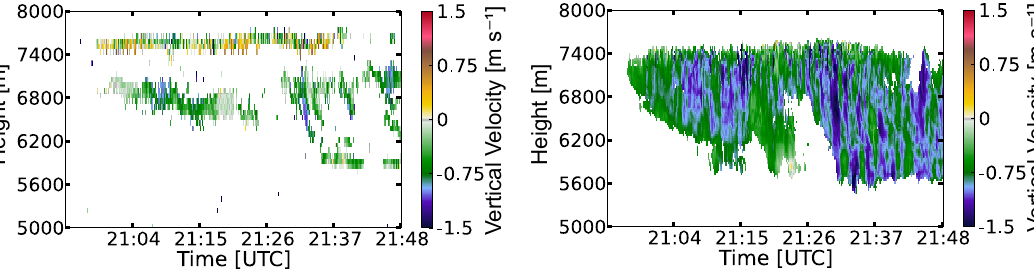
Figure 6. Vertical velocity for case 2. Left: derived from lidar (valid for more numerous smaller droplets at cloud base); right: derived from radar observations (valid for large particles;